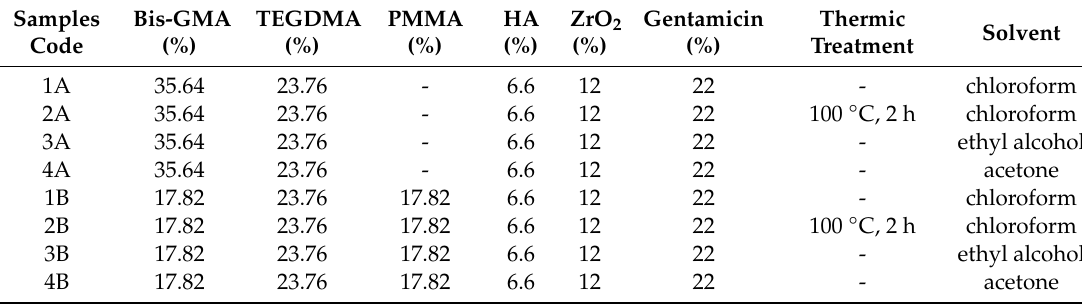
Table 1. FRC matrices composition, the thermic treatment and the solvent used to extract the residual